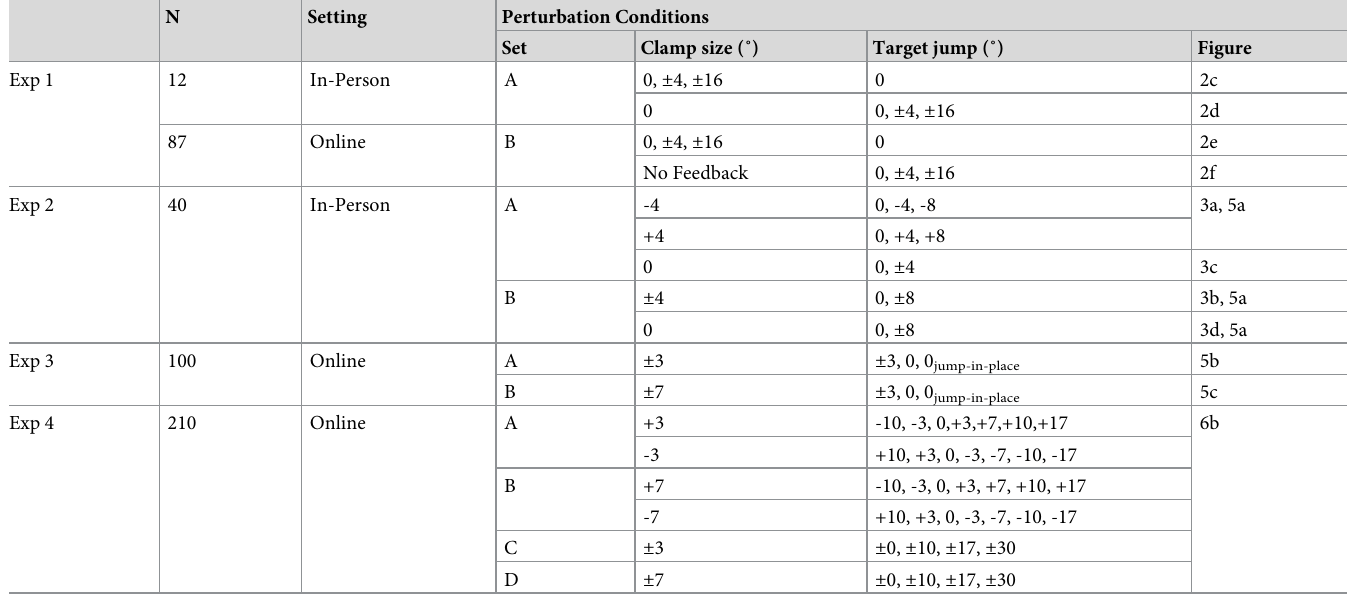
Table 1. Summary of